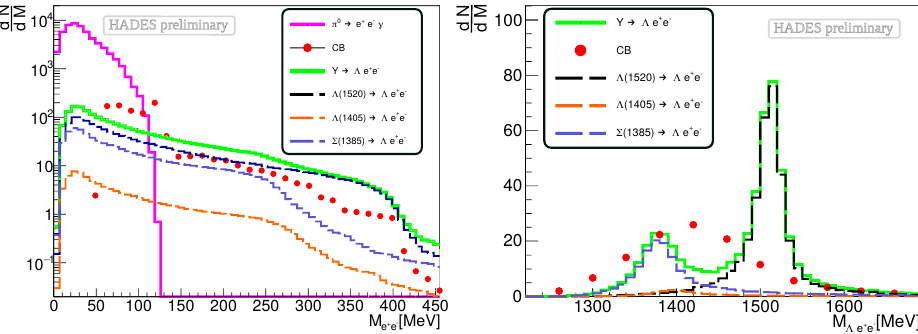
Figure 2. Left: di-lepton invariant mass spectrum. Thee green solid line shows the sum of all signal channels, dashed lines show each channel separately (see legend), red dots came from combinatorial background, magenta solid line is a contribution from π 0 Dalitz decay. Right: invariant mass for pairs Λ 0 - di-lepton, for M e + e − > M π 0 . Color code the same like in